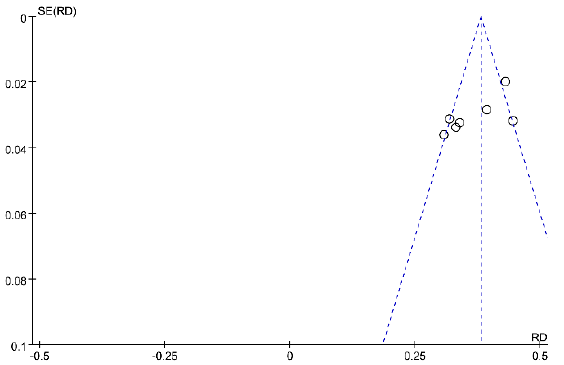
Figure 4. Forest plot of prevalence estimates of seven studies of postpartum depressive symptoms.